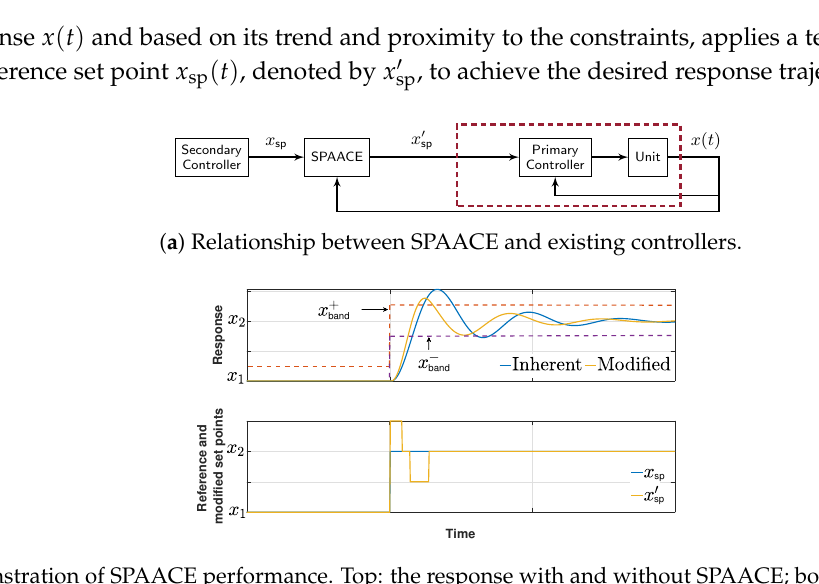
( b ) Demonstration of SPAACE performance. Top: the response with and without SPAACE; bottom: the modified set point created by SPAACE. Figure 1. Fundamentals of the SPAACE